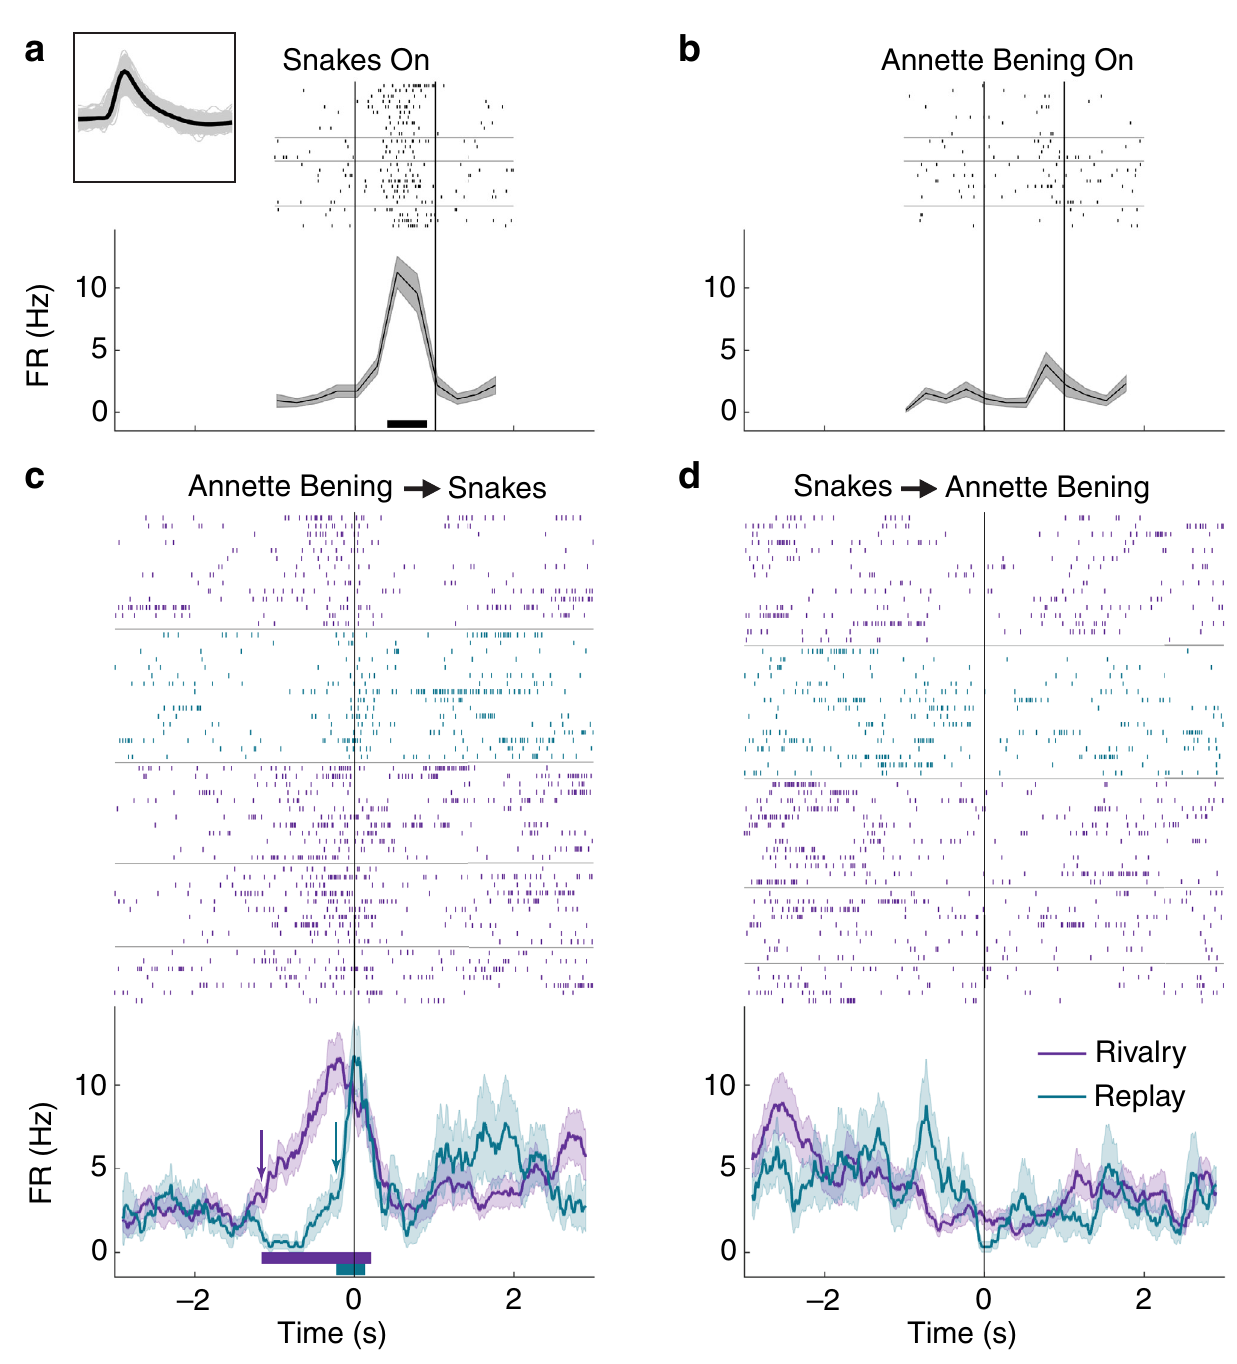
Fig. 3 Activity of a single-unit in amygdala during rivalry and replay. Conventions as in Fig. 2. a , b Responses to the non-rivalrous presentation of snakes ( a ) or the actress Annette Bening ( b ) images. c Neuronal fi ring around the report of transition onset to the snakes image ( t = 0; end of Annette Bening image exclusive dominance) during rivalry (purple) and replay (cyan). d Neuronal fi ring around the report of transition onset to the Annette Bening image. Note the strikingly different onset of fi ring in rivalry and replay. Behavioral reports from this session are presented in Fig.